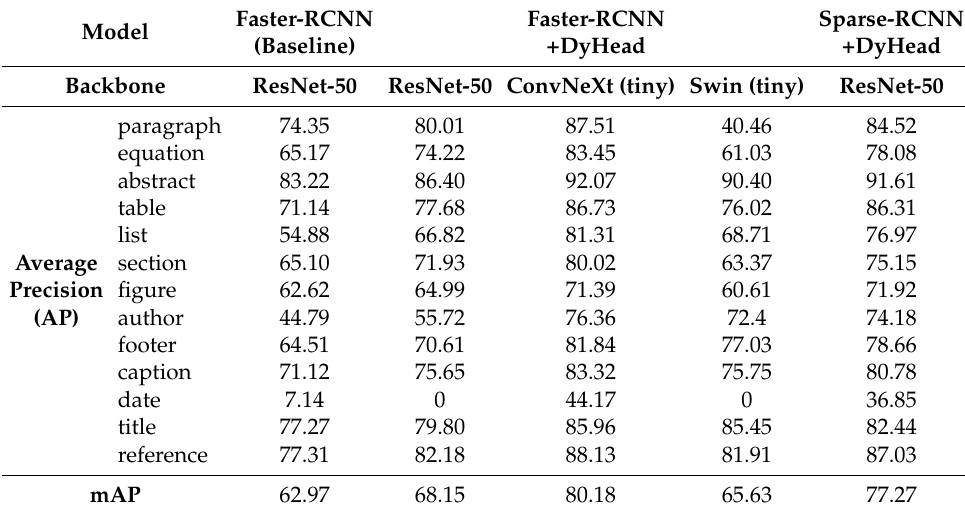
Table 2. Performance evaluations of DocBank using Faster-RCNN with different backbones. Re- sults with Sparse-RCNN using ResNet-50 backbone are also presented. For Faster-RCNN+ResNet- 50, the inclusion of the attention mechanism improves the mAP by 5.18. The Faster- variants containing DyHead by a large margin.